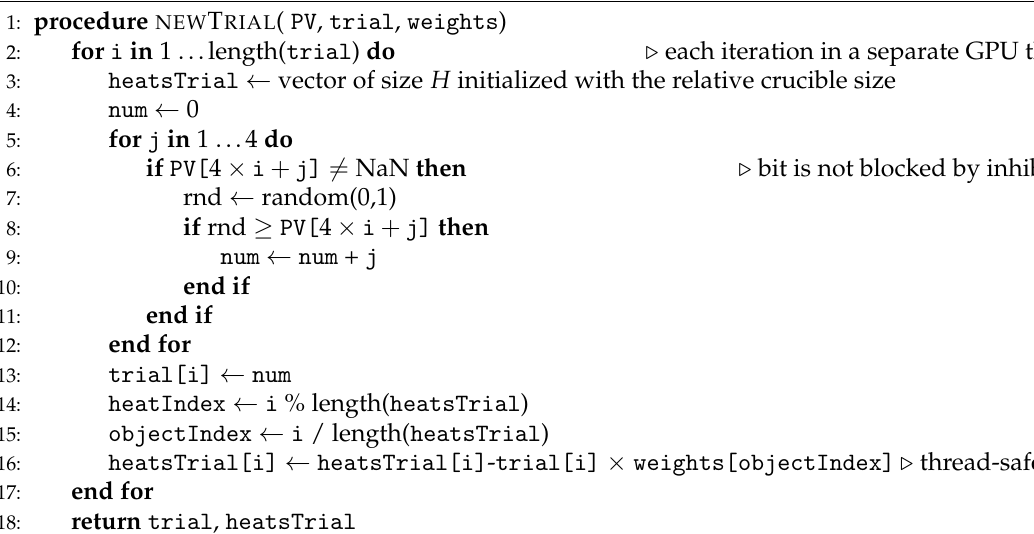
Algorithm 10 Discrete cGA: